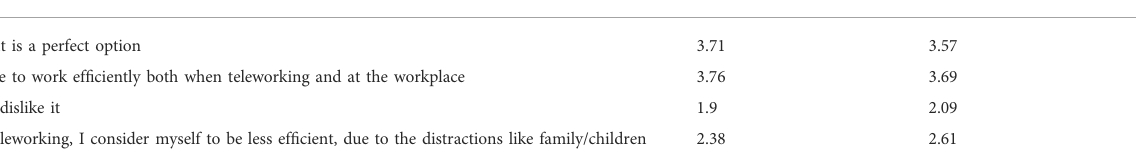
TABLE 2 Positions regarding teleworking (medium scores).